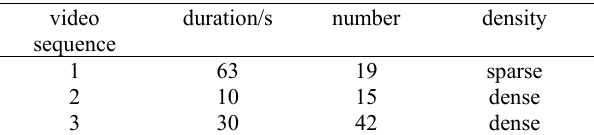
Table 2 . Traffic statistics experiment test video information.